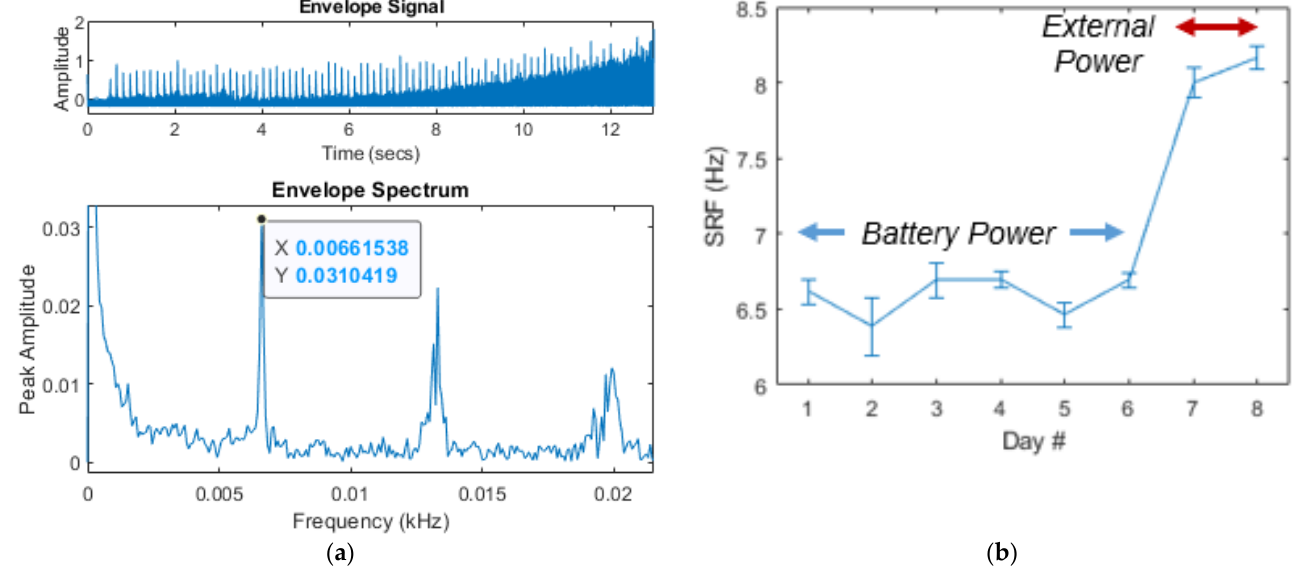
Figure 7. Results of 𝑆𝑅𝐹 computation: ( a ) envelope signal and envelope spectrum for acoustic data from Day#1; ( b ) computed 𝑆𝑅𝐹 and their fluctuations across all days of experimentation.